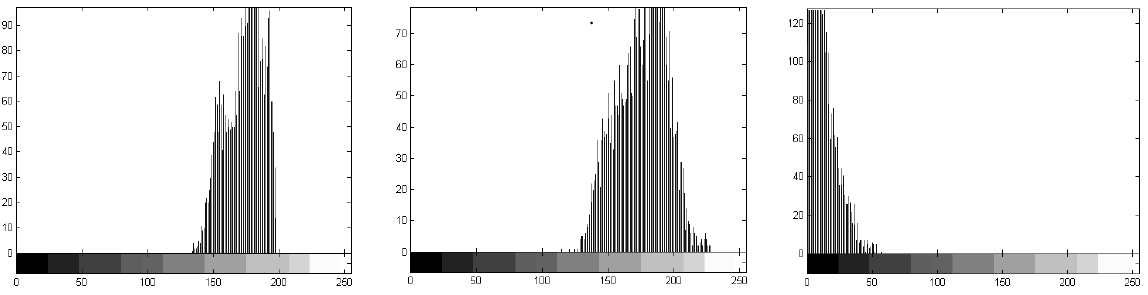
Fig. 3. The histograms of Fig. 2(a), Fig. 2(c) and Fig. 2(d).